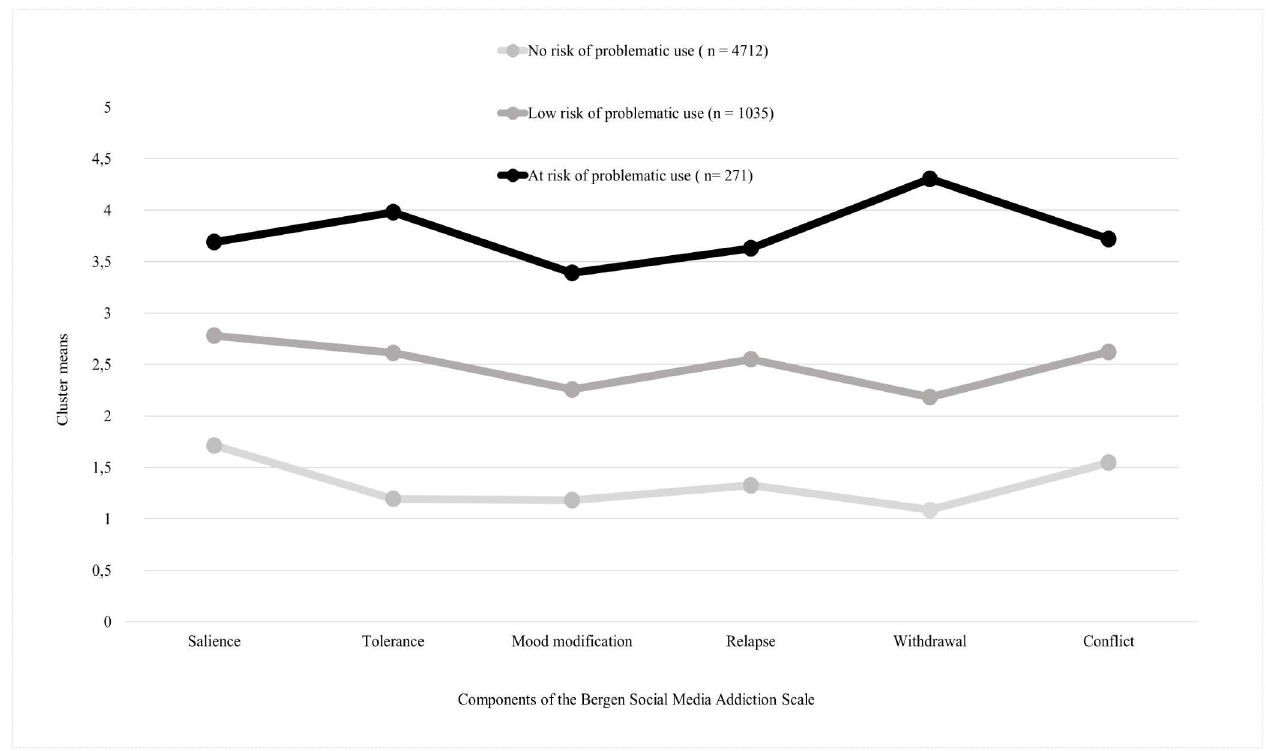
Fig 1. The Three ClassesObtained from the Latent Profile